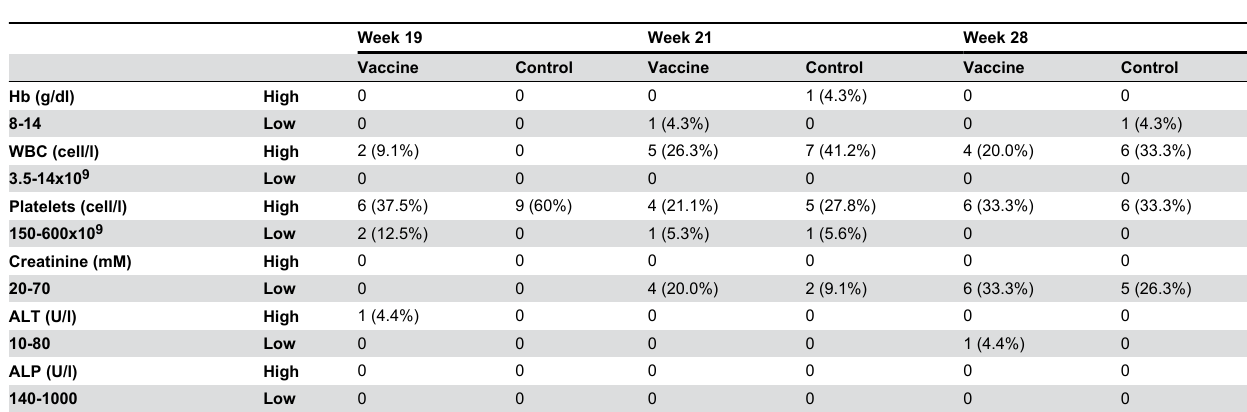
Table 4. Frequency of biochemical and haematological abnormalities.